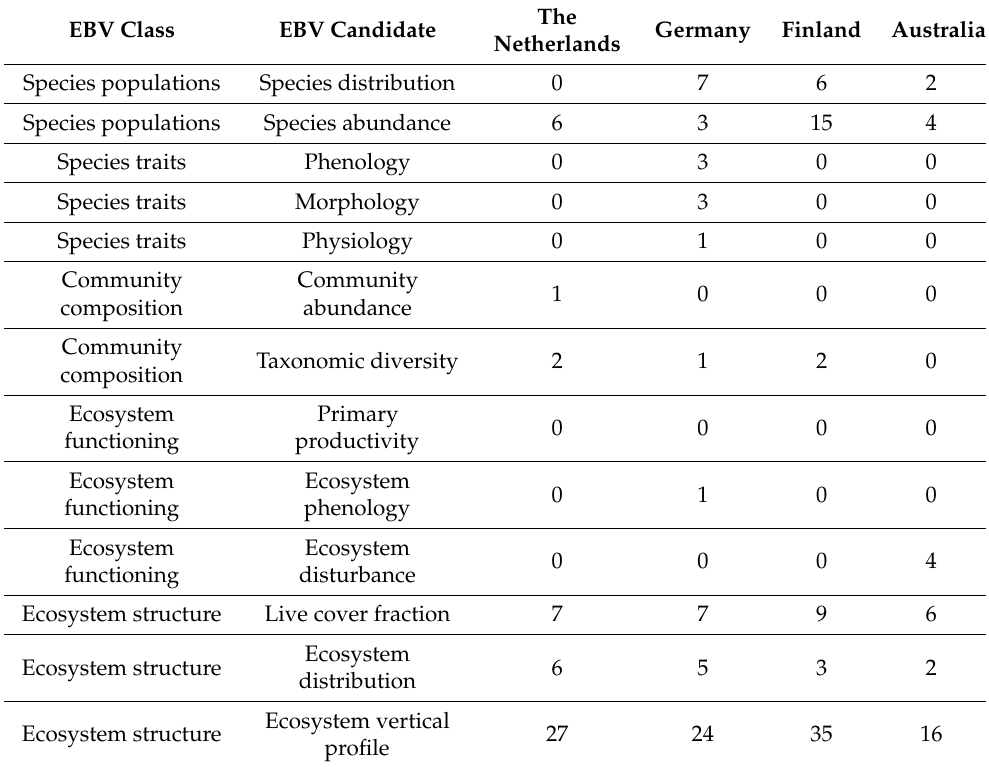
Table 3. The number of indicators of the examined policies per country across the candidate EBVs. EBV Class EBV Candidate